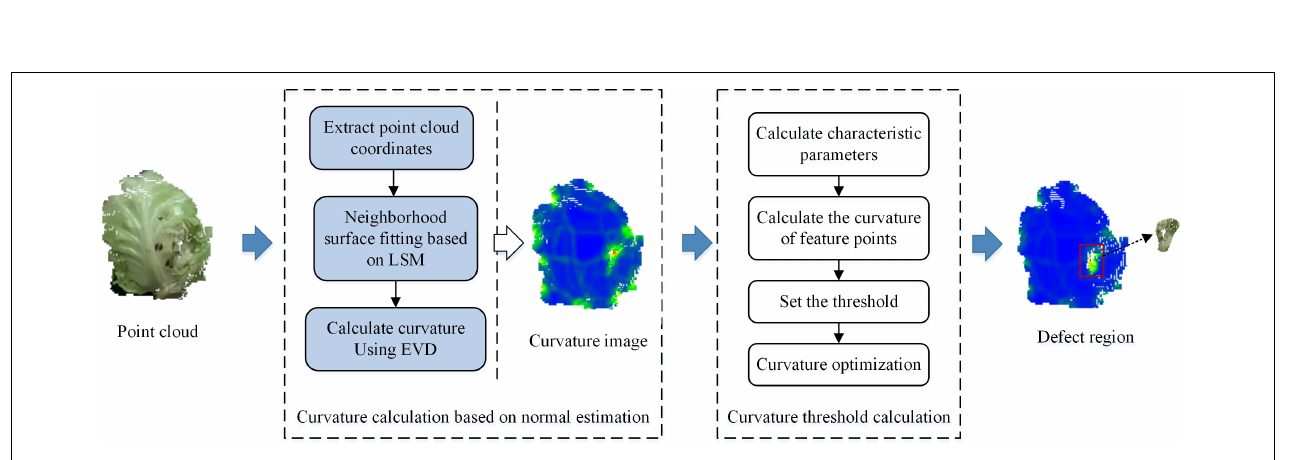
FIGURE 8 | Defective area extraction